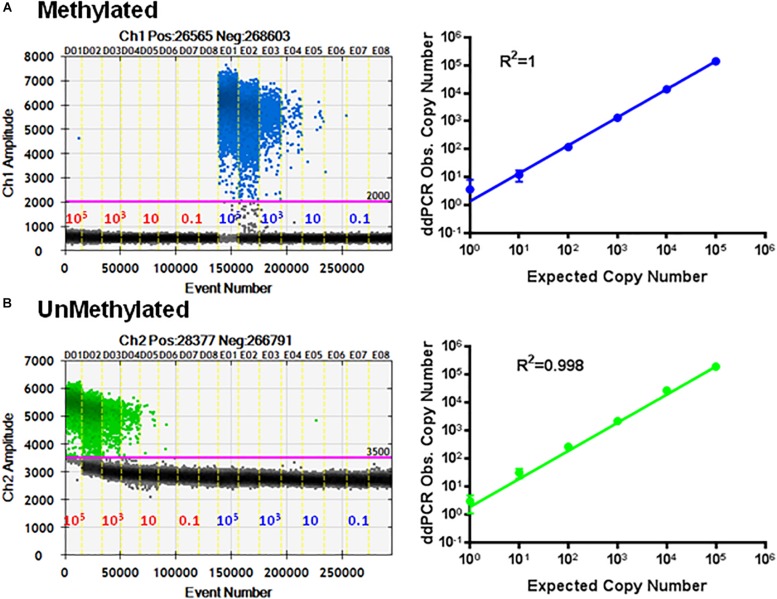
Specificity of ddMSP assay. Standard curves of methylated (A) and unmethylated (B) FOXP3 TSDR in the same reaction. ddPCR using serially diluted mixed plasmids (105–0.1 copy/reaction) and two TSDR-specific primers with probes for methylated and unmethylated CpGs. Standard curves with linear regression analysis of methylated and unmethylated targets. The data shown are the average with standard deviation (SD) of three repeats.